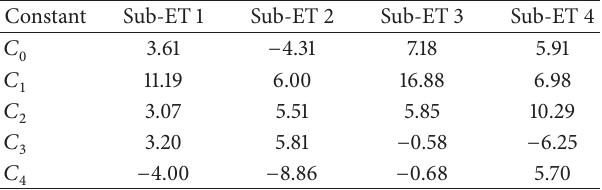
Table 5: Constants in the GEP